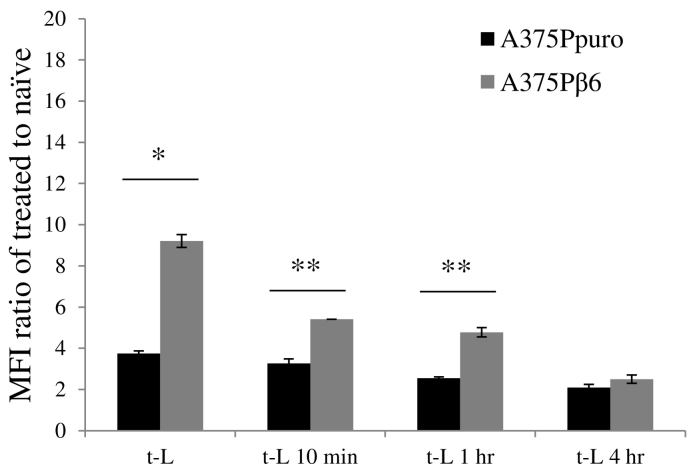
Effect of incubation of t-L with mouse serum on targeting efficacy. t-L were exposed to mouse serum for various lengths of times (10 min, 1 h, 4 h). The melanoma cell lines, A375Ppuro and A375Pβ6 were incubated with these liposomes for 1 h. Results are displayed as the MFI fold increase of naïve cells. Incubation of t-L with mouse serum leads to a reduction in receptor-mediated uptake cell uptake in the αvβ6 positive A375Pβ6 cell line. Cellular uptake was assessed by measuring the MFI using flow cytometry and FL-1 detector. Values are expressed as mean ± SD (n = 3). *p < 0.05, **p < 0.01, (Student's t-test A375Ppuro vs. A375Pβ6).